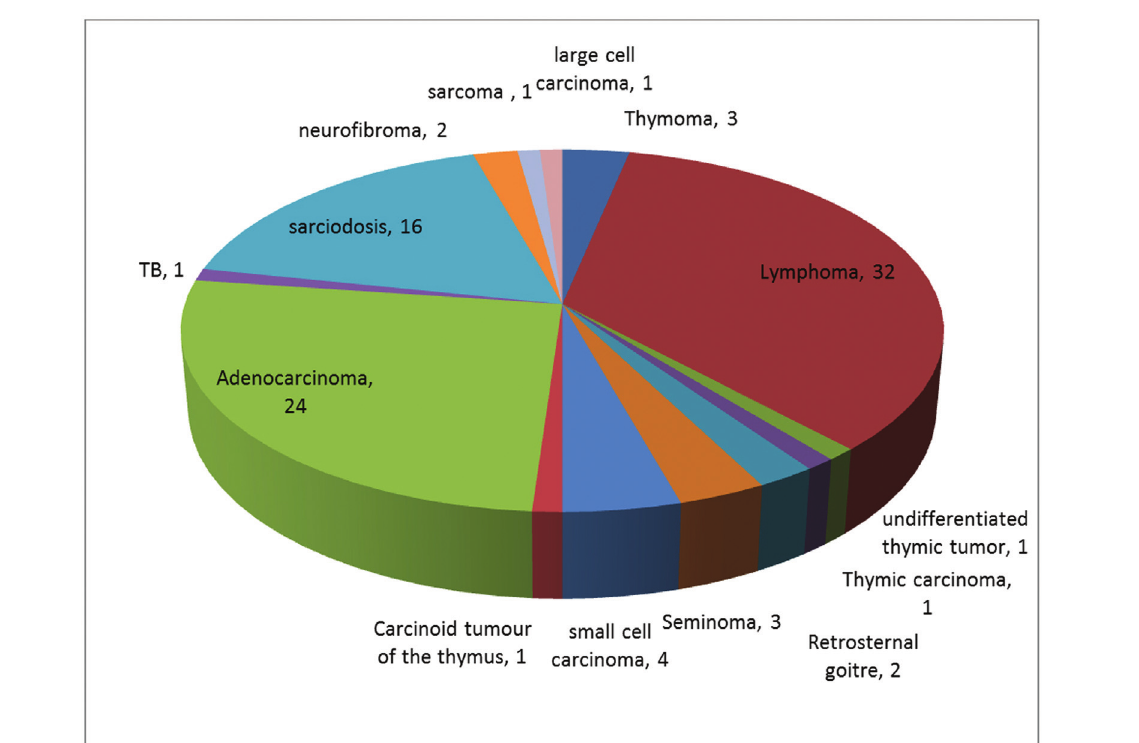
Spectrum of pathological diagnosis.